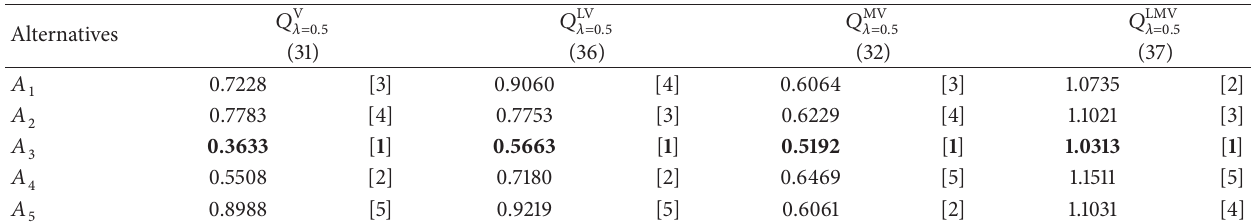
Table 13: Ranking of alternatives with respect to values of 𝑄 V , 𝑄 L + V , 𝑄 MV , and 𝑄 LMV for 𝜆 = 0.5 .